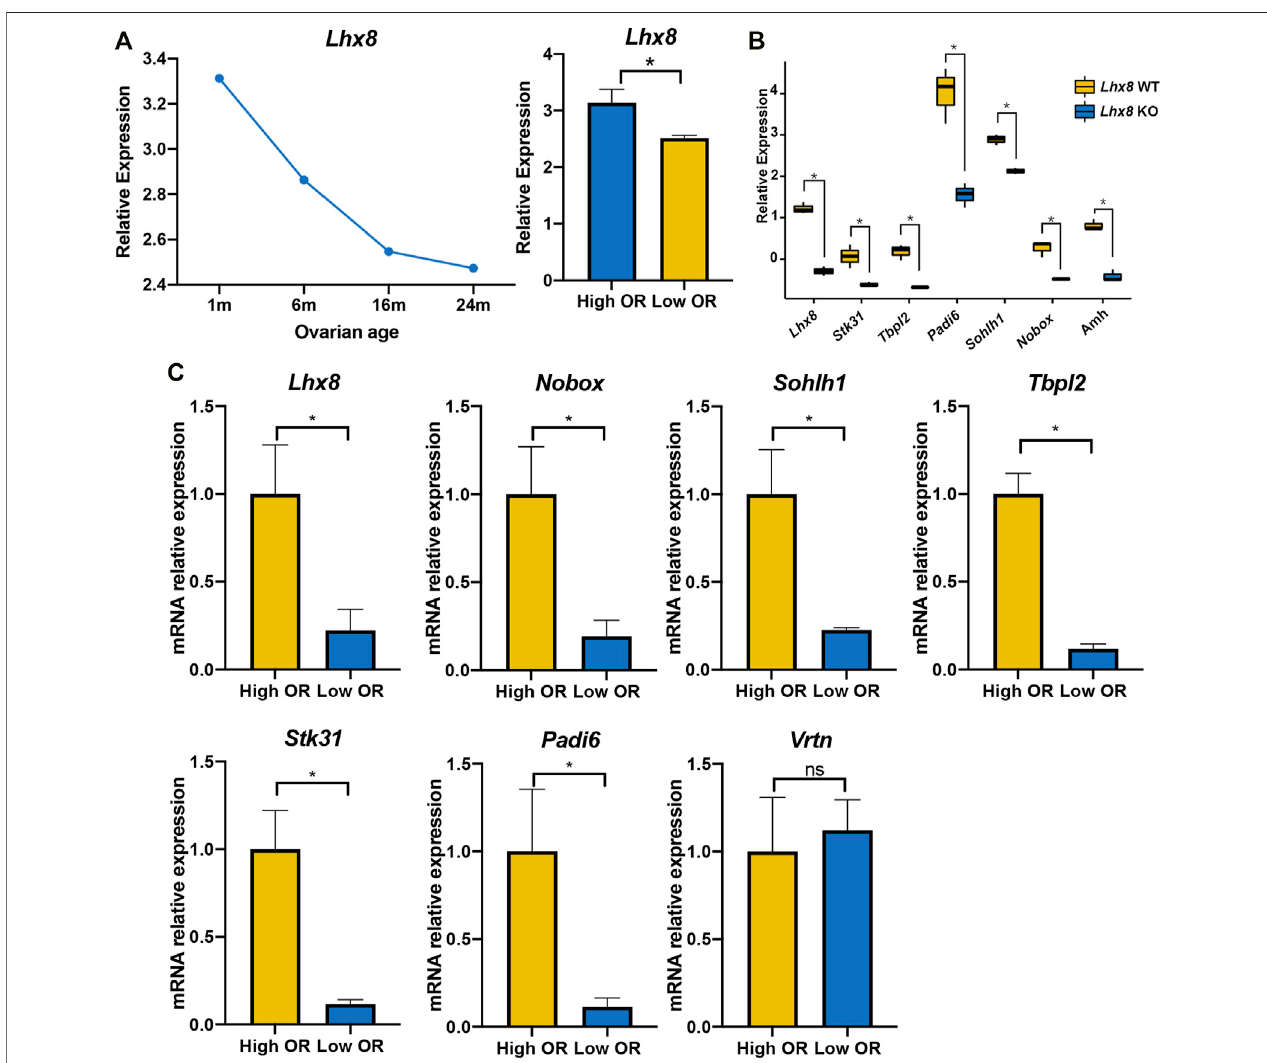
FIGURE 6 | Validation of seven identi fi ed genes expression by DOR models. (A) The Lhx8 expression of the entire ovary with different murine BOA from mRNA microarray dataset GSE7502, High OR (1- and 8-month-old group), low OR (16- and 24-month-old group). *, p < 0.05. (B) The gene expression of the entire ovary in Lhx8 WT(wildtype)and Lhx8 KO(knockout)frommicroarray datasetGSE109473;*, p < 0.05. (C) ThegenesexpressionoftheentireovaryfromourHighOR(2-month- old, n = 3) and Low OR (8-month-old, n = 3) mice. *, p < 0.05; ns, p > 0.05.